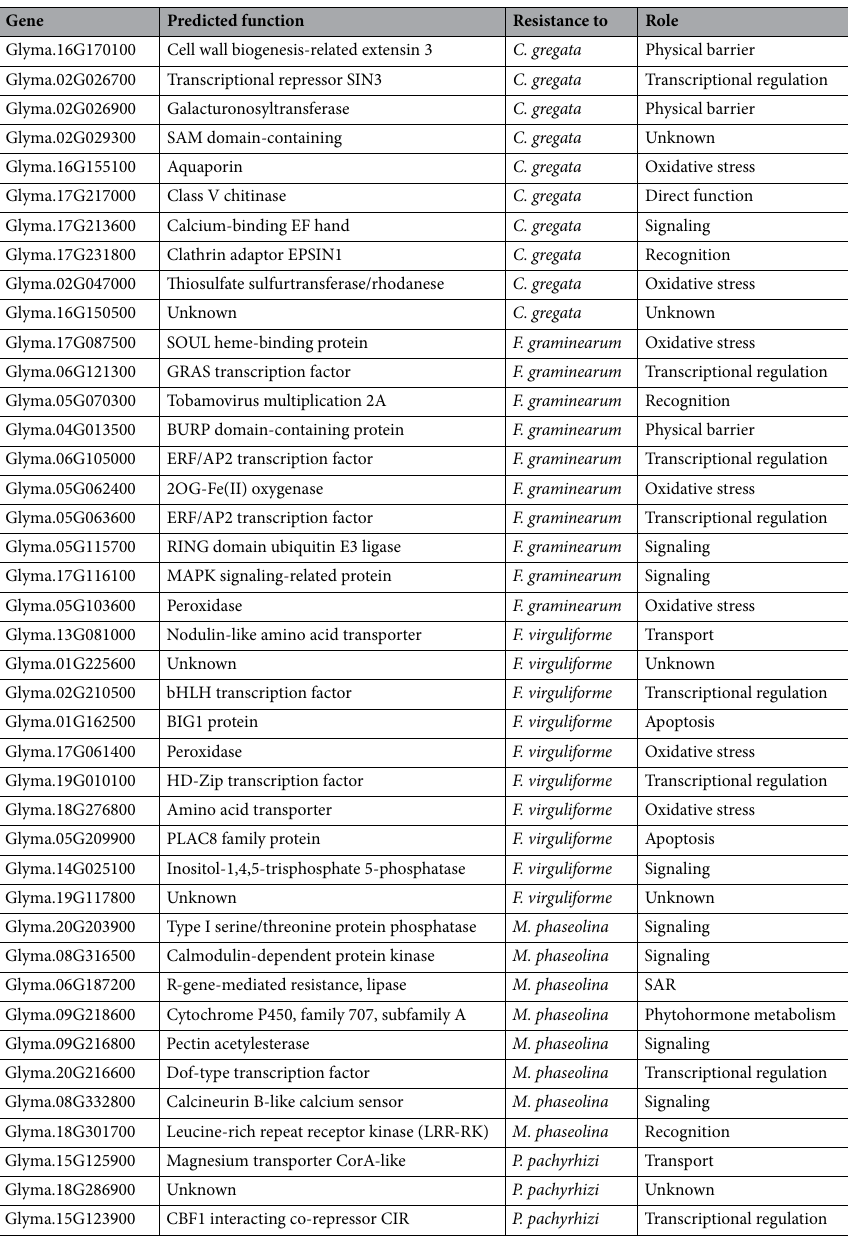
Table 2. Top 10 candidate resistance genes against each fungal species and their putative roles in plant immunity. The predicted function for each gene was manually curated from the description of the best ortholog in Arabidopsis thaliana , using functional annotations from Soybase and